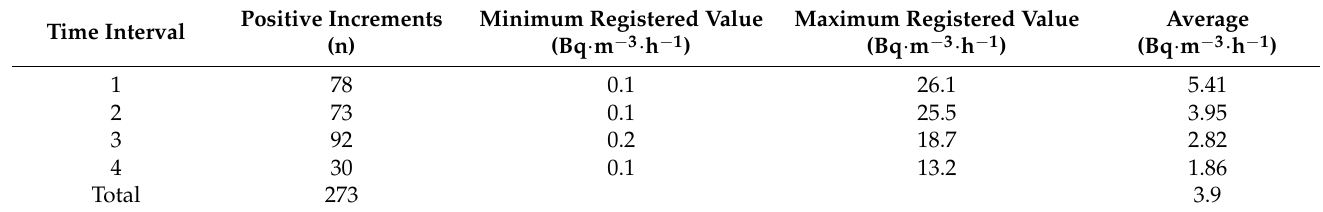
Table 1. The hourly average value of the increments recorded in the periods when the indoor Rn concentration rises or